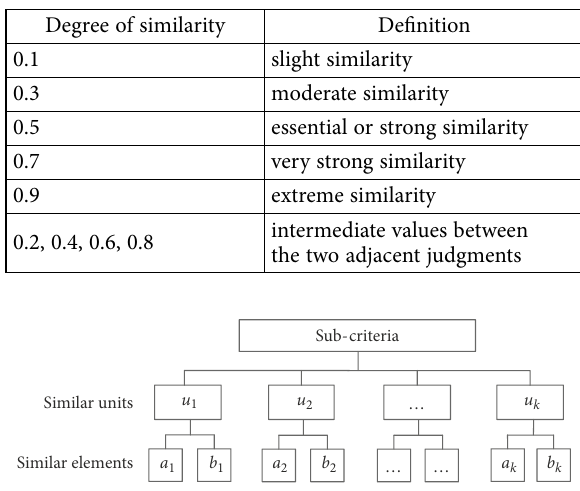
Table 4. Pair-wise similarity